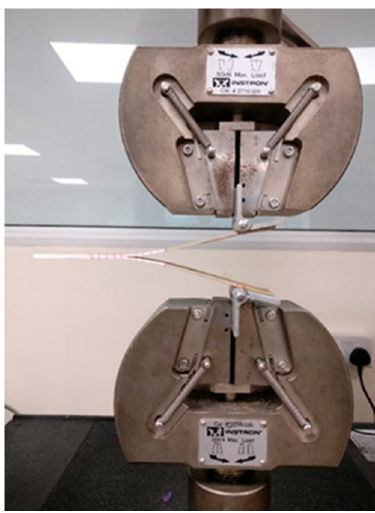
Figure 5. DCB specimen under test.